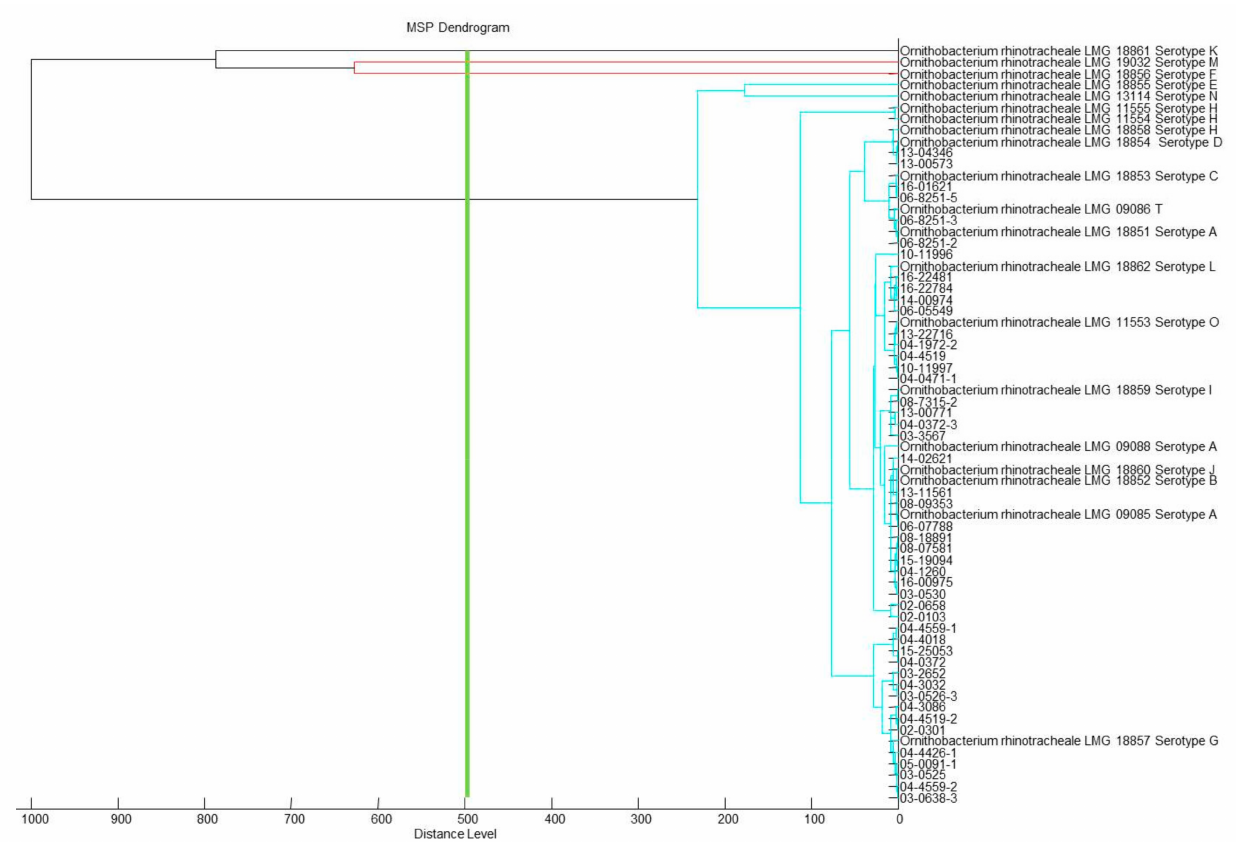
Figure 2. MSP dendrogram based on MALDI-TOF MS of 47 field strains isolated from different geographical areas in Austria and different